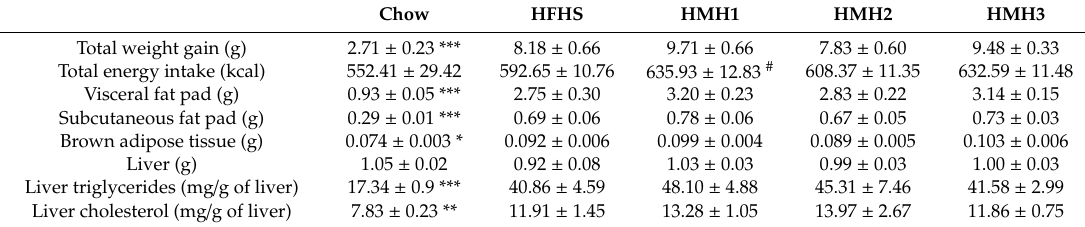
Table 2. E ff ect of the HMH treatments on body